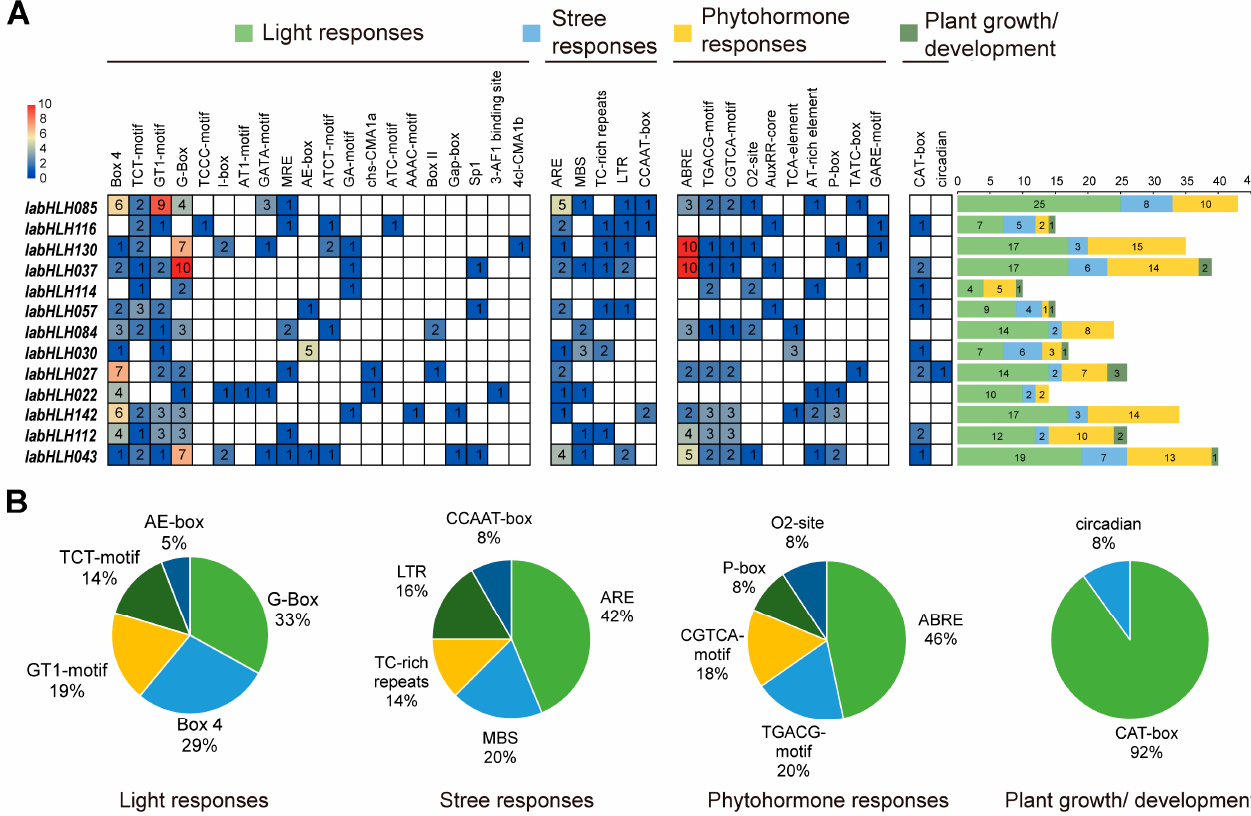
Figure 8. Cis-acting elements within the promoter region of the 13 DEGs. ( A ) Heatmap of the cis- acting elements. The stacked bars on the right side indicate the number distribution of different cis- acting elements in the 13 DEGs; ( B ) percentage of different cis-acting elements in the respective class.